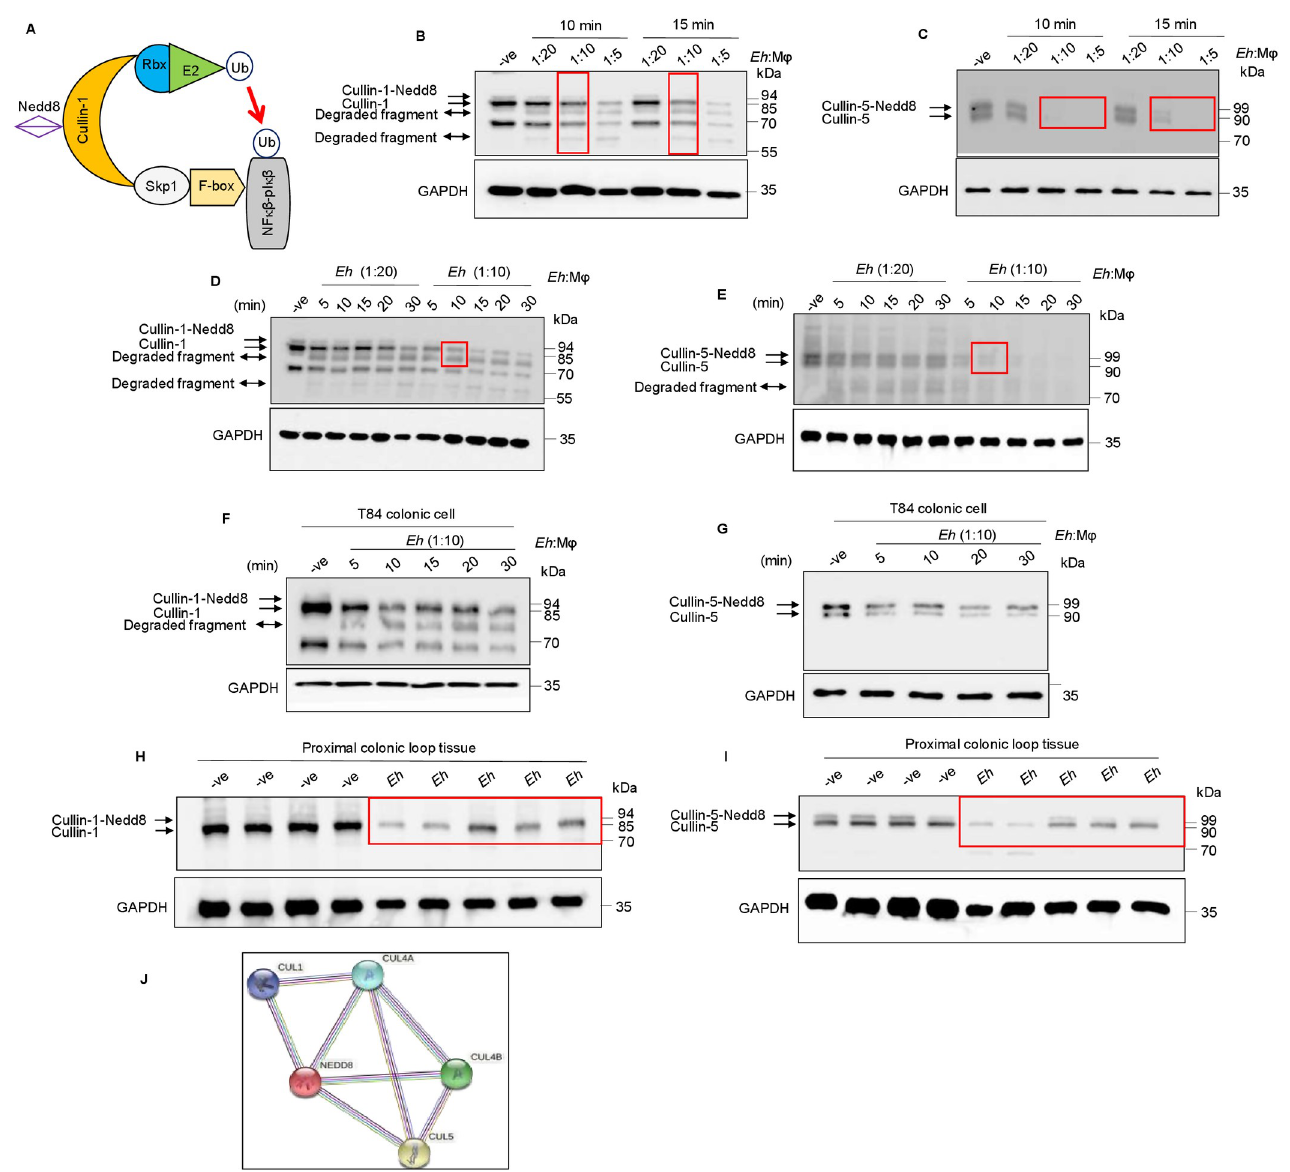
Fig 1. Entamoeba histolytica promotes the degradation of cullin-1/5 from THP-1 derived macrophages, colonic epithelial cells, and proximal colonic loop tissues in a time- and dose-dependent fashion. (A) Schematic representation of Skp-1-Cullin-1-F-box (SCF) protein E3 complex (Skp-1: S-phase kinase- associated protein 1; Rbx: RING [Really Interesting New Gene]-box1; E2: Ubiquitin-loaded E2). (B, C) THP-1 macrophages were incubated with different Eh : macrophage ratios, or (D, E) for increasing times (5 to 30 min) with Eh (20:1 ratio) and Eh (10:1 ratio). (F, G) T84 colonic epithelial cells were grown in 12-well plates and stimulated with Eh (10:1 ratio) for 5 to 30 min. (H, I) Proximal colonic loops were inoculated with Eh and cell lysates were prepared. Post Eh stimulations, cells were washed and cytoplasmic extracts were prepared, and an equal amount of protein was loaded on to the SDS- PAGE gel (7.5%) and immunoblotted with the anti-cullin-1, anti-cullin-5 and anti-GAPDH antibody. Highlighted boxed areas on the figures show point of interest for cullin-1/5 as described in text. (J) Protein-protein interaction using STRING v11 showed direct interaction between cullin-1, cullin-5, cullin-4A, cullin-4B and Nedd8. Data (B, C, D, E, H, and I) are representative of three independent experiments and data (F and G) are representative of two independent experiment and statistical significance was carried out with Students t- test. Bar represent mean ± SEM. �� P < 0.01, ��� P < 0.001. production was unaffected [25]. This unique pro-inflammatory signature is dependent upon live Eh in direct contact with macrophages that activates the NLRP3 inflammasome pathway [24,35– 37], as purified native Gal-lectin is a potent stimulus for TNF- α transcription and protein release